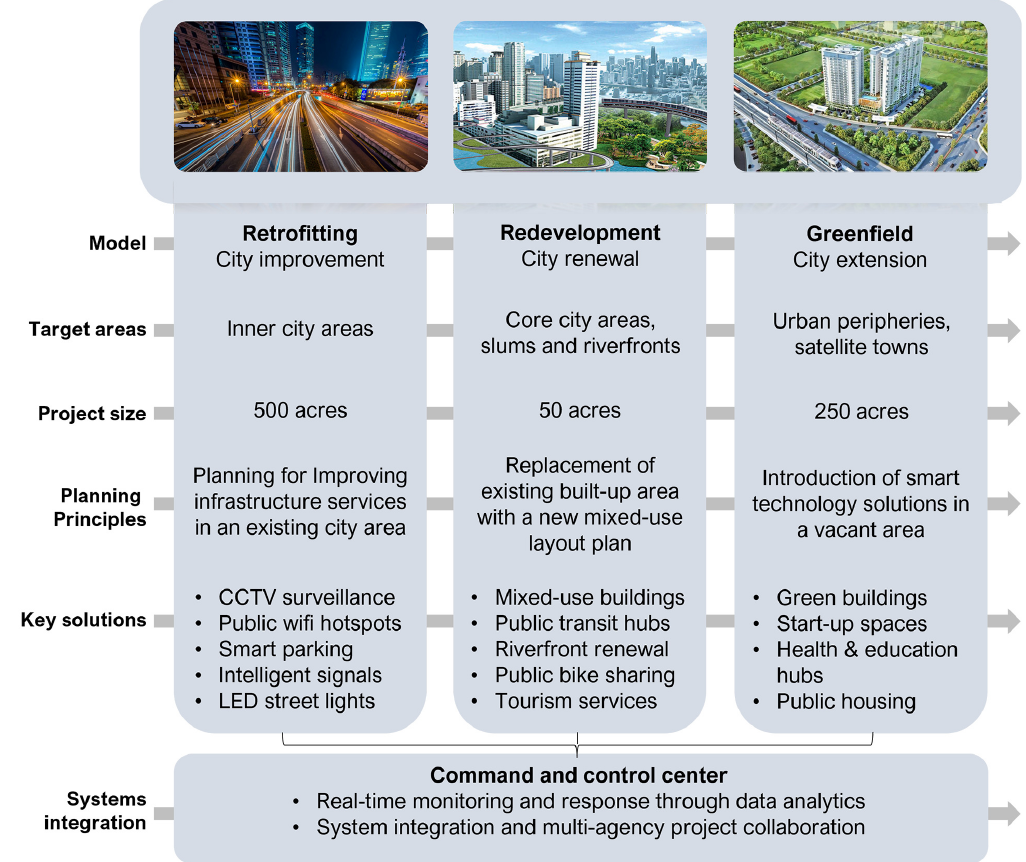
Figure 1. ABD model of the smart cities in